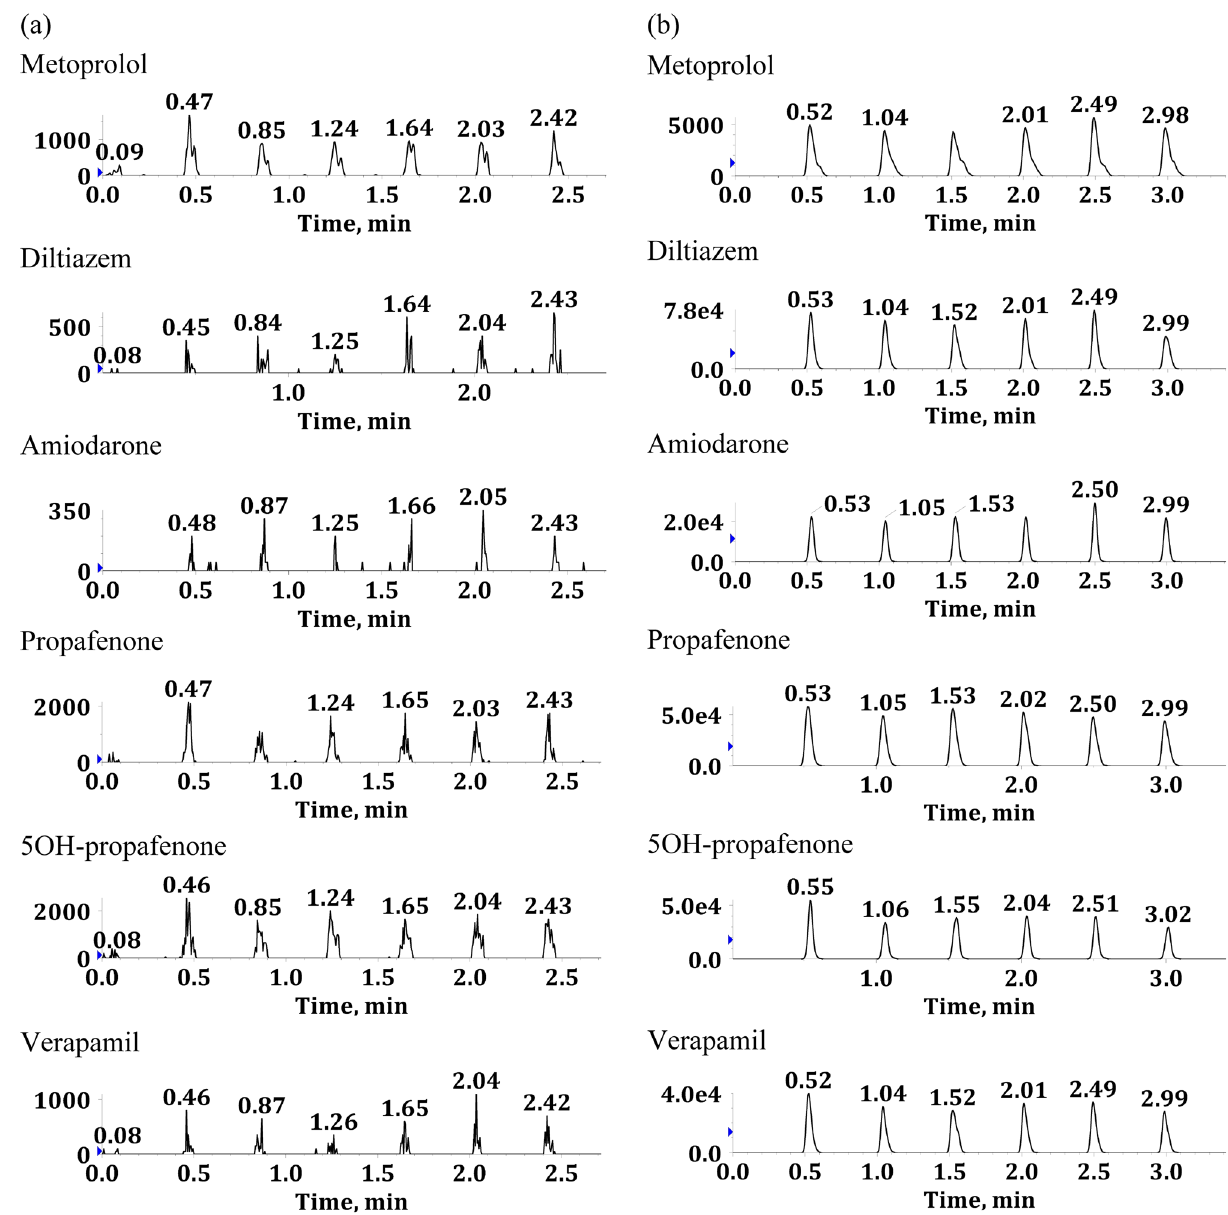
Figure 3. Representative chronograms of drug-free serum ( a ) and spiked with LLOQ level ( b ) in six different sources.